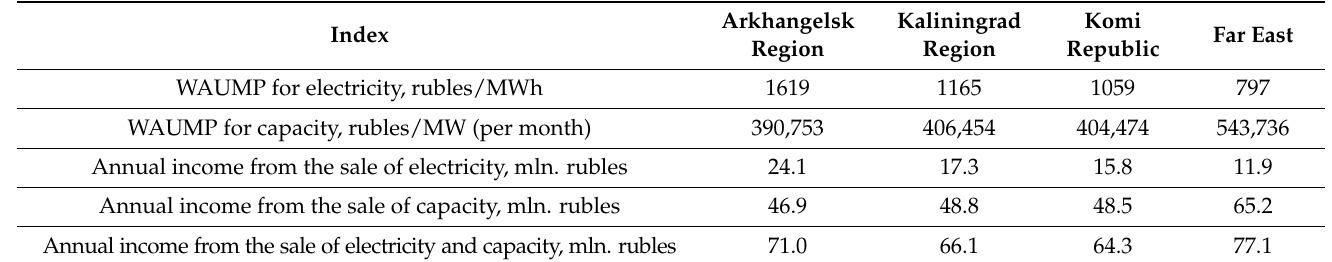
Table 6. Maximum income of an SPP in non-price zones of the wholesale electricity